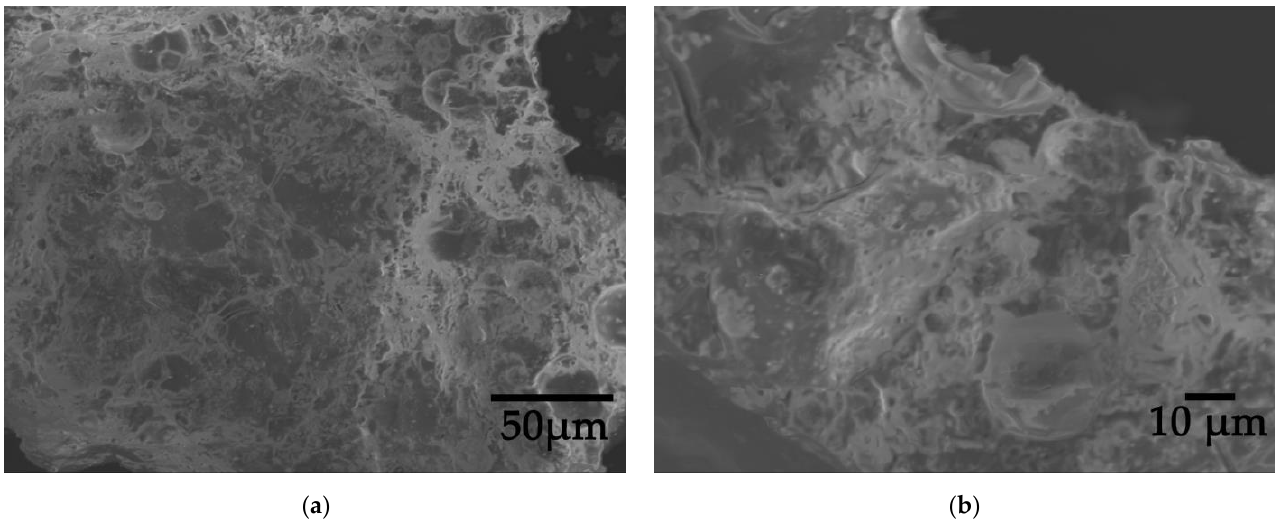
Figure 5. SEM images of sample G2 ( a ) at 500× magnification; ( b ) at 1000× magnification. Table 5. Elemental composition based on